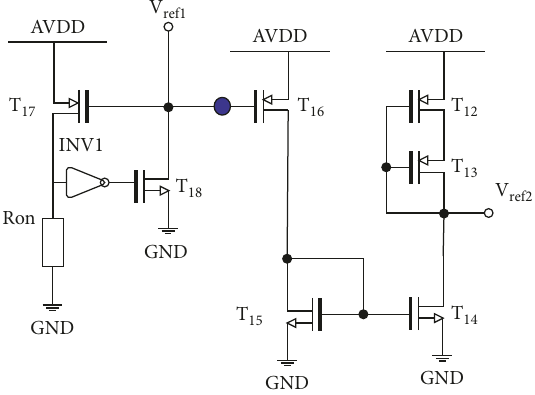
Figure 4: Current source bias